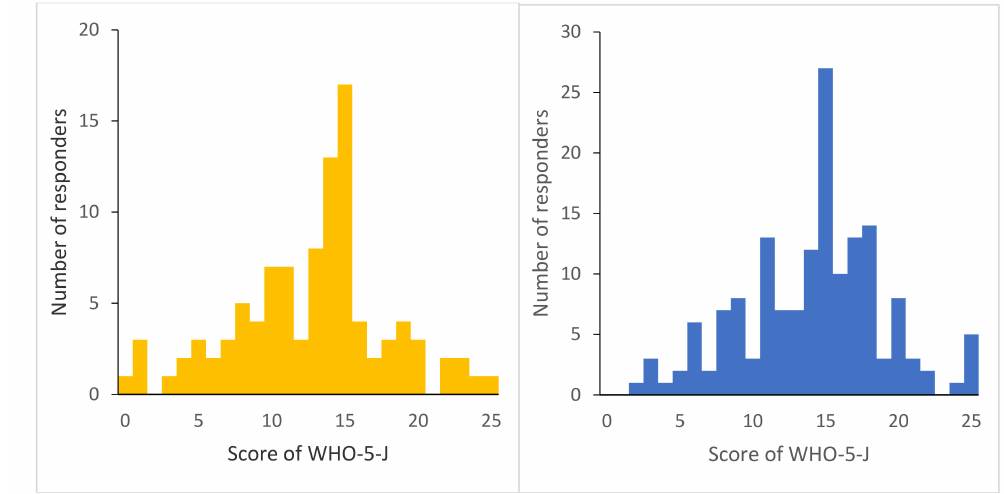
Figure 1. Distribution of the score of the Japanese version of the World Health Organization Five Well-being Index (WHO-5-J). Left : RPH group (n = 101), Right : non-RPH group (n =